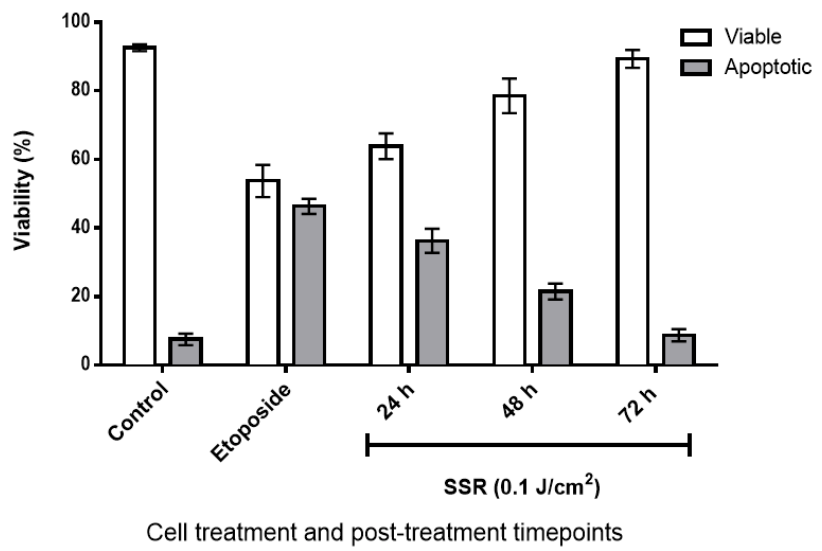
Figure 1. Cell viability determined by Annexin V staining and flow cytometry. HaCaT cells were irradiated with 0.1 J / cm 2 SSR and then stained with Annexin V and propidium iodide, and